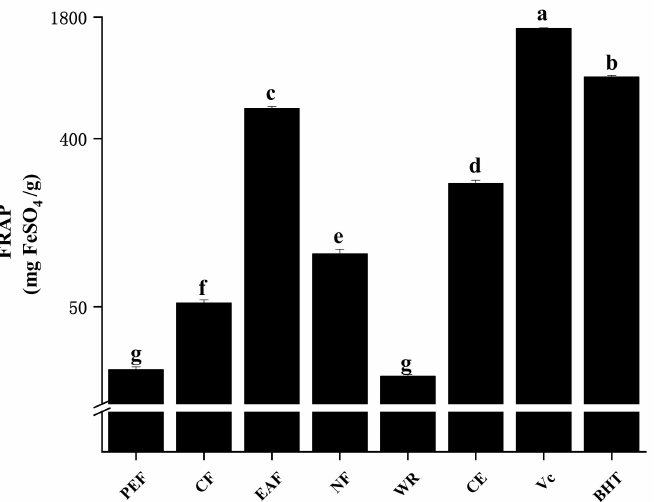
Figure 3. The ferric reducing antioxidant power of samples. The different letters in the column represented significantly difference ( p < 0.05).